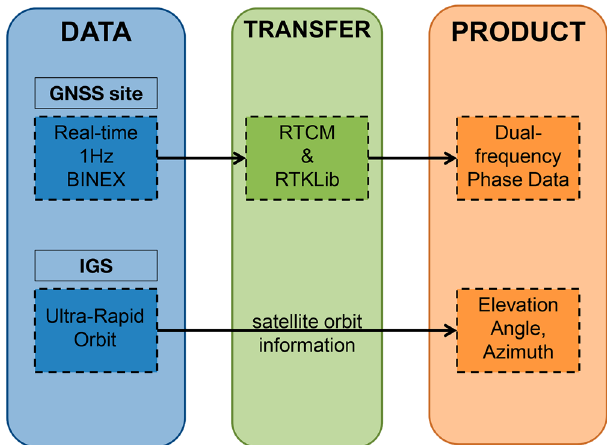
Figure 1. Real-time collection of GNSS phase data and orbit parameters. Networked Transport of RTCM 26 via Internet Protocol (NTRIP) 27 could be used to provide the real-time data stream from GNSS stations. The main goal of the protocol is Real Time Kinematics (RTK), but it is also suitable for our purposes since it transfers dual-frequency phase and pseudo-range data in real time. RTKLib 28 software could be used to convert binary information from NTRIP data stream. The International GNSS Service (IGS) ultra-rapid orbit 29 is used to obtain the information about the elevation angle and the azimuth. BINEX Binary INdependent EXchange format for files that is used in